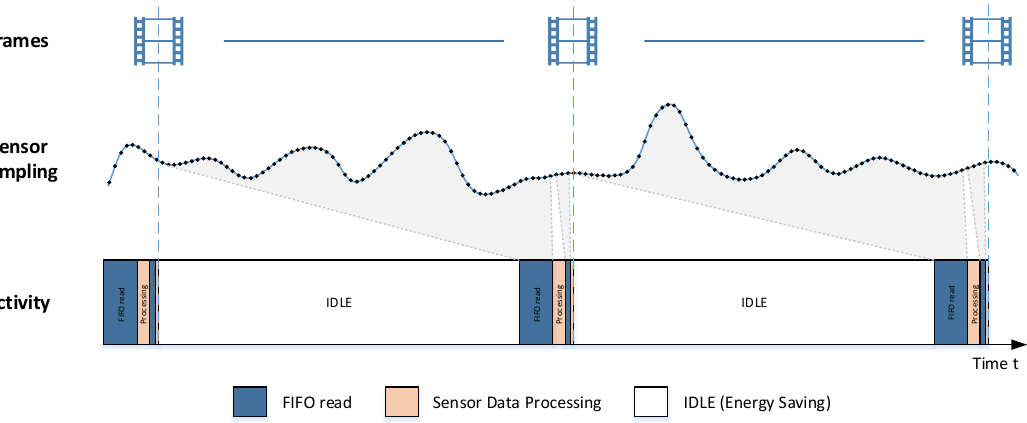
Figure 3. Using the FIFO interface of the sensor can lower the power consumption and avoid data loss. By double-reading the FIFO content, it is also applicable on low latency